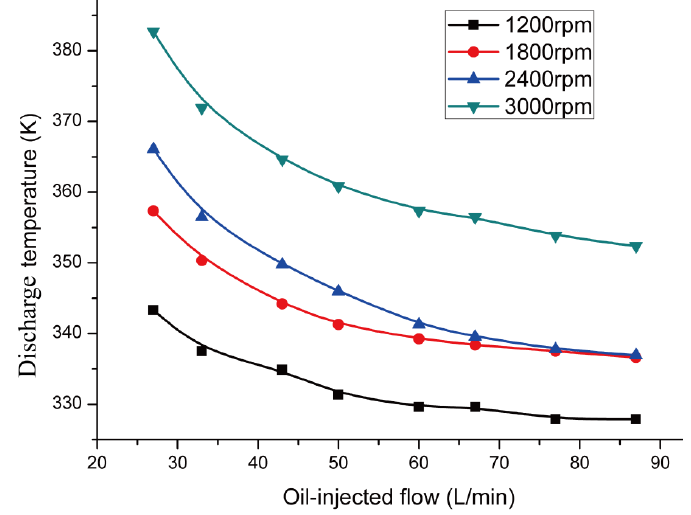
Figure 4. Variation of discharge temperature at different oil ‐ injected flow rates.